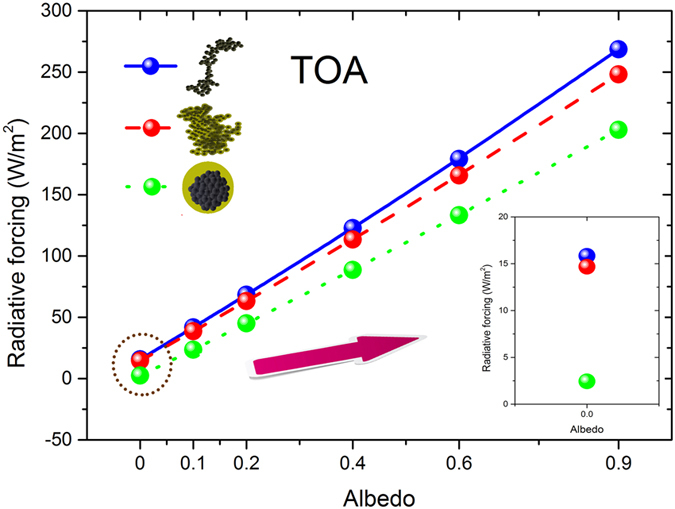
Similar as Fig. 3, but at TOA.